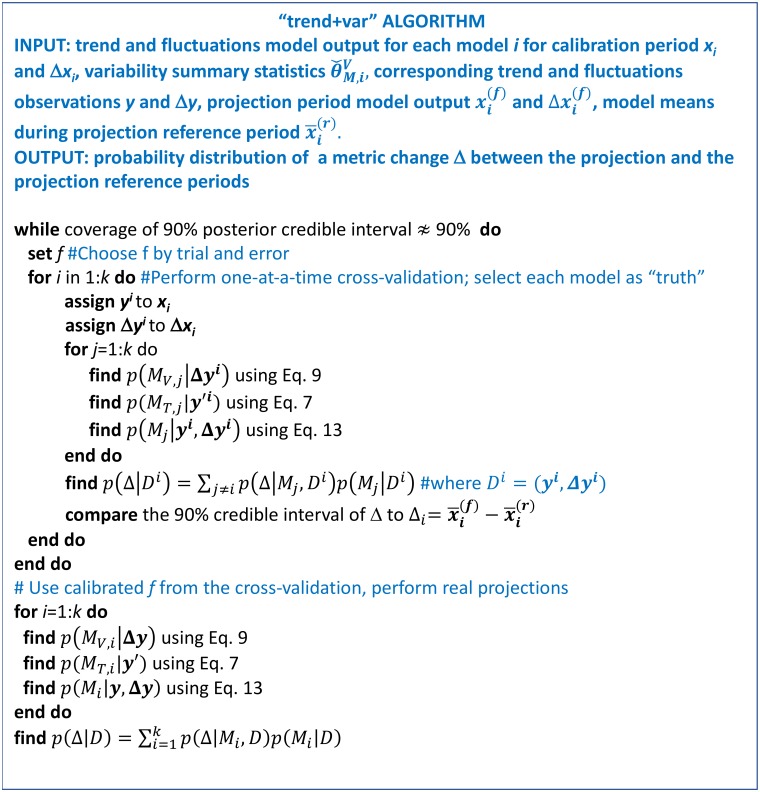
“trend+var” algorithm.